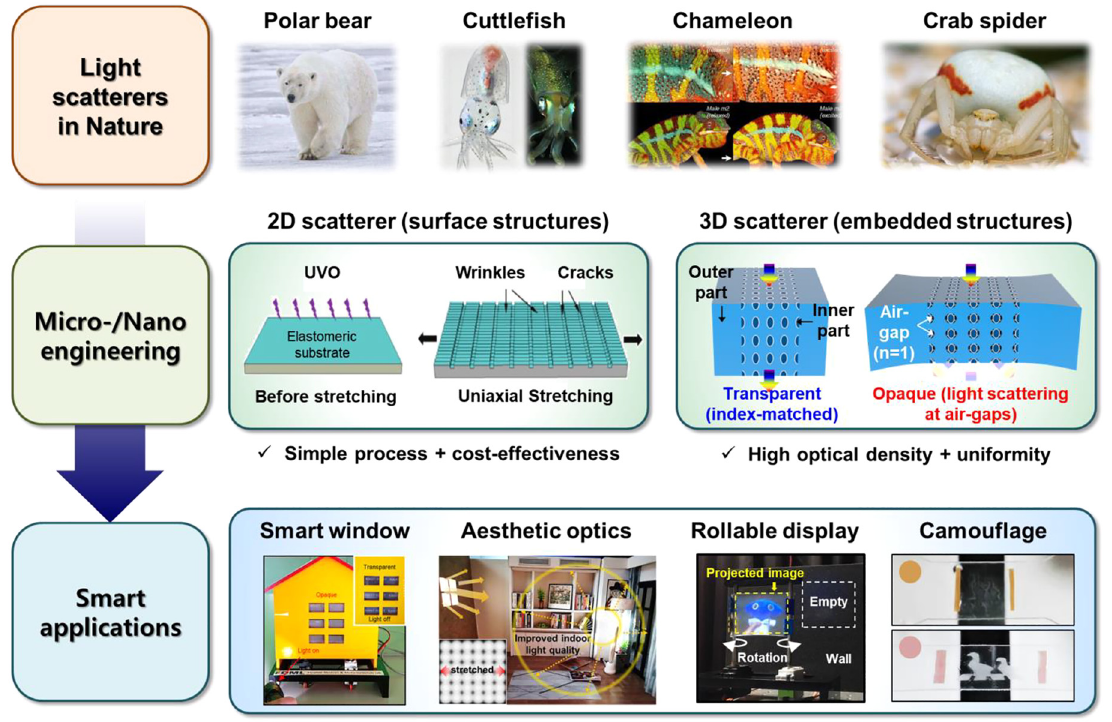
Figure 1: Schematic showing light scattering in bio-optics and optical engineering for smart applications. Reprinted with permission from Refs. [3, 17, 18,